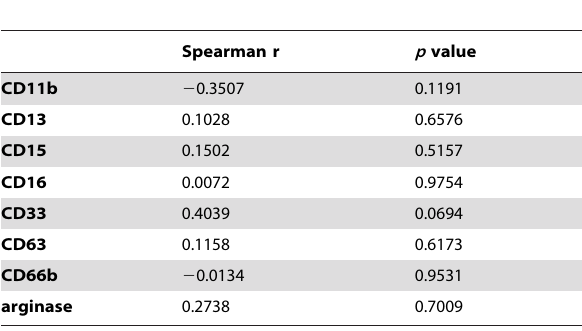
LDGs were isolated from the blood of HIV + patients with CD4 + T cell counts . 350 cells/ m L (n=11) or , 350 cells/ m L (n=10) as described in materials and methods and the correlations between CD4 + T cell counts and phenotypic markers were determined by a Spearman’s rank test.